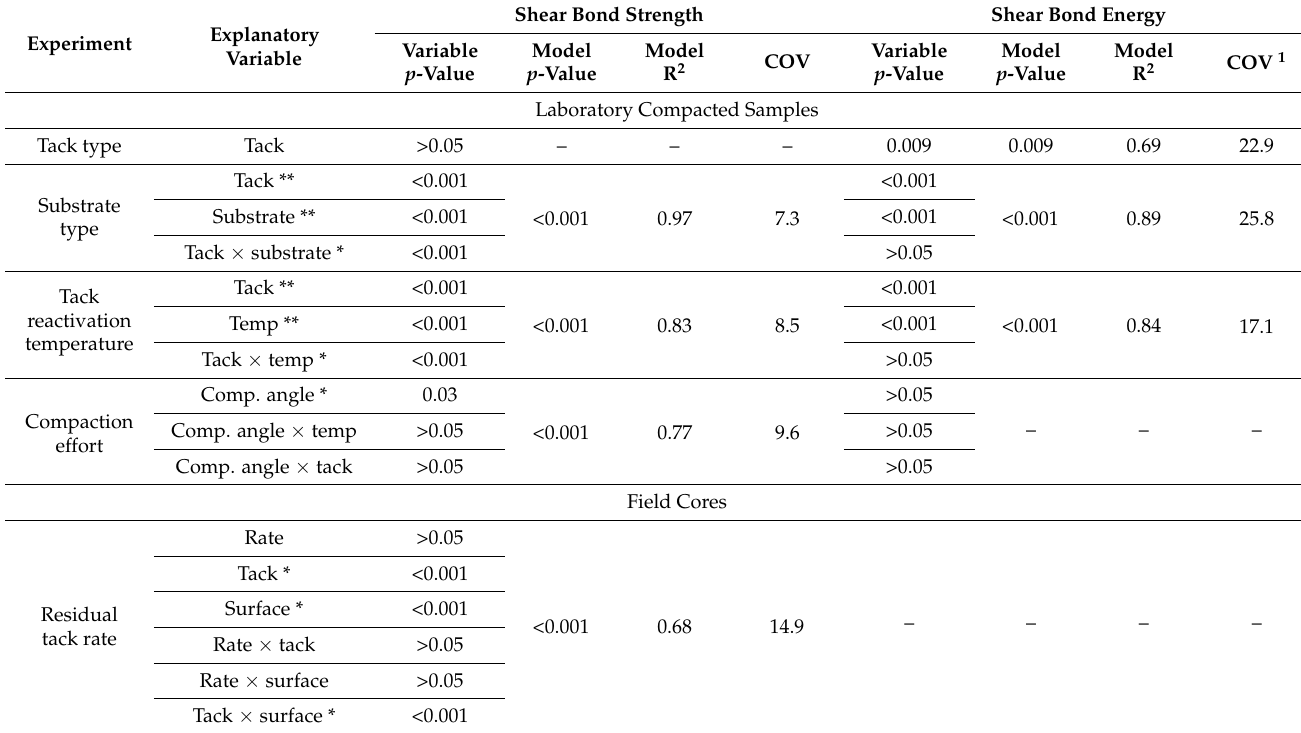
Table 3. Results of the statistical analysis of shear bond strength and